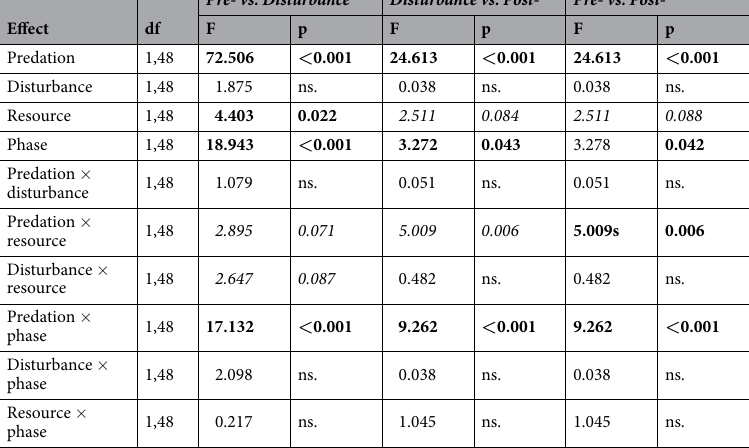
post-disturbance (F 1/24 = 8.657, p = 0.002; post-disturbance F 1/24 = 11.262, p = 0.001 respectively). Resource dep- rivation was only significant in the pre-disturbance/disturbance comparison, while interaction between predation explained by the effect of predation (Supplementary Fig. S9).